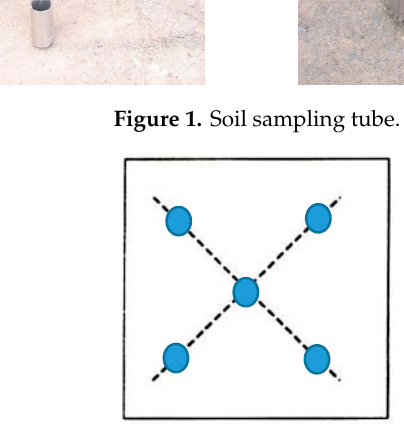
Figure 1. Soil sampling tube .